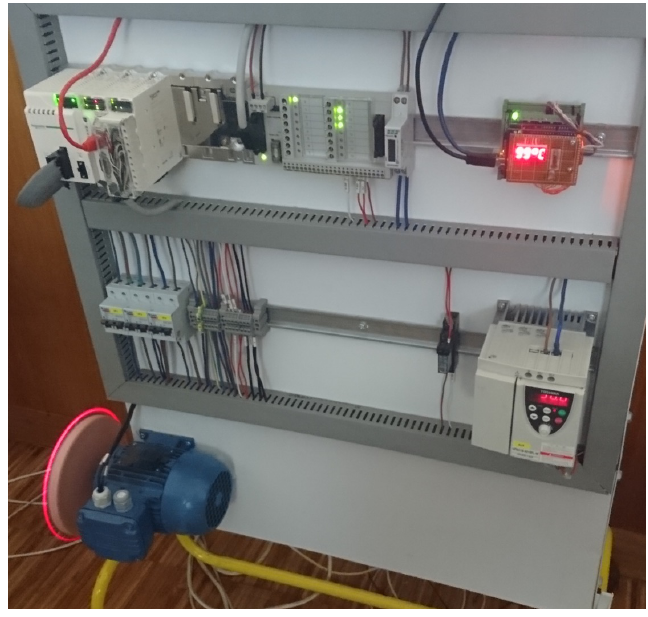
Figure 3. Automation